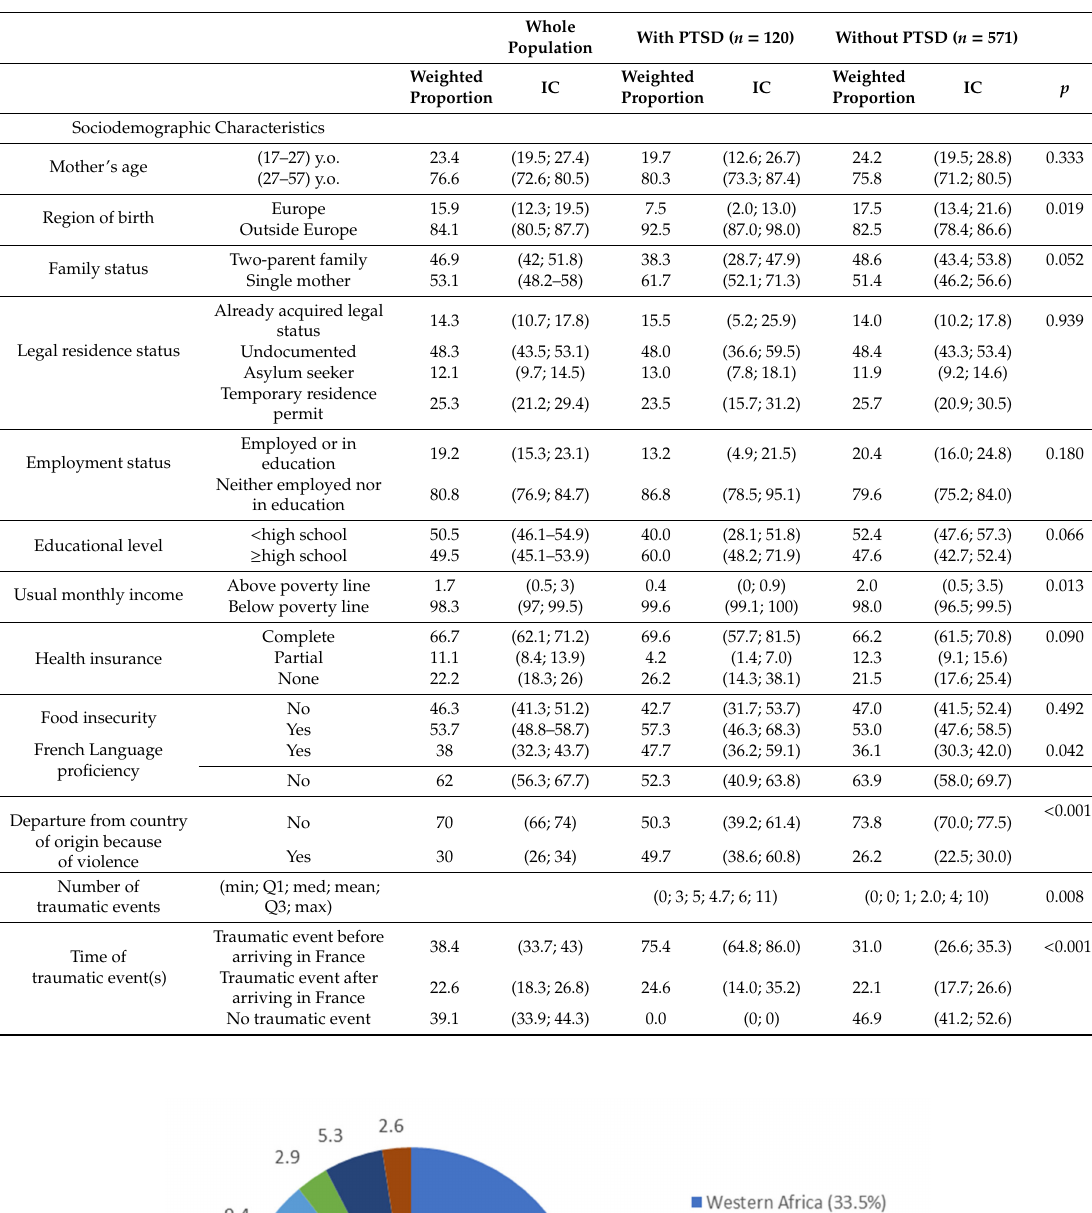
Table 1. Sociodemographic characteristics of homeless migrant mothers in the Paris region (ENFAMS survey 2013, n = 691).